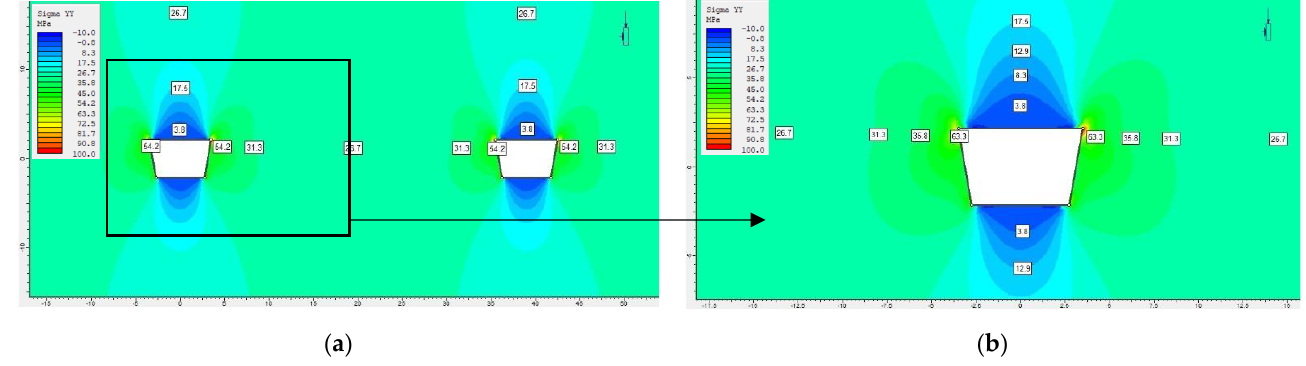
Figure 7. Distribution of σ YY stresses in the cross-section through ramps drilled in dolomite: ( a ) view of both headings; ( b ) close-up of a single excavation.